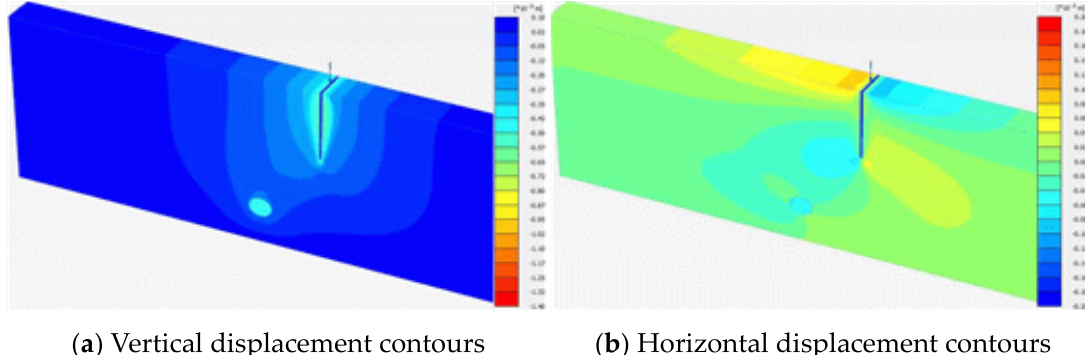
Figure 22. Displacement contours for allowable load (case 3-3).